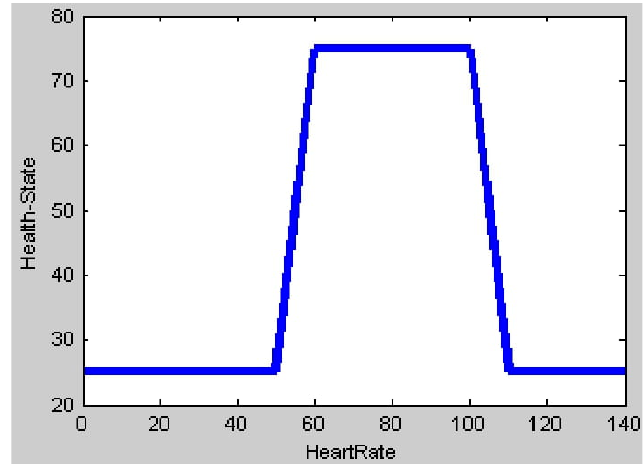
Figure 16. Output plot for Heart rate input.